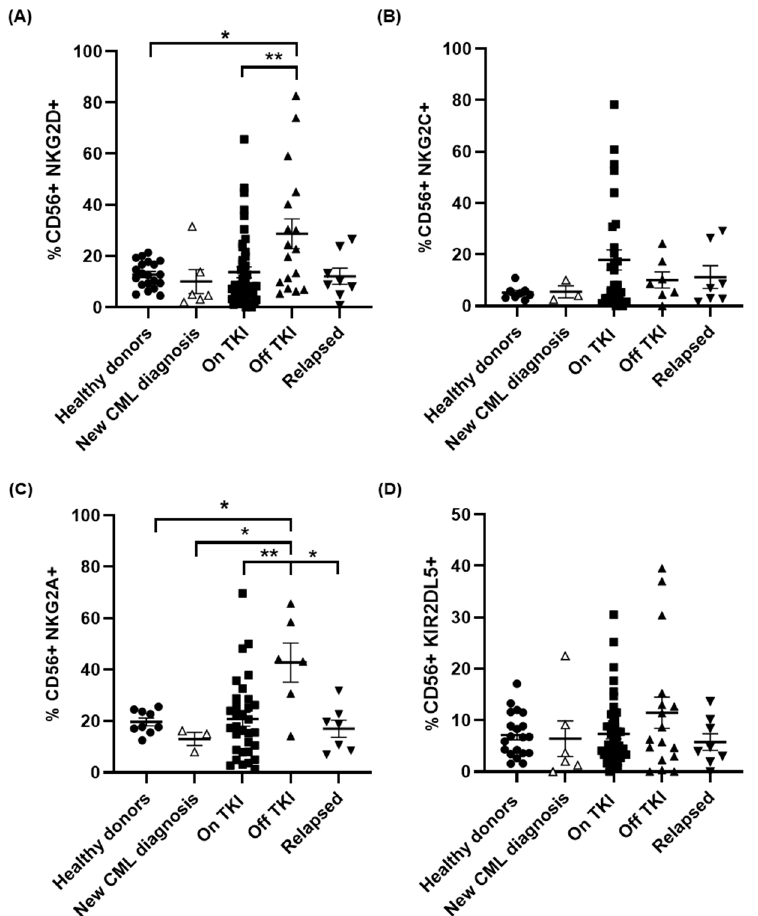
Figure 3. Differential expression of activating or inhibitory receptors in NK cells in the different groups of patients. Analysis by flow cytometry of the expression of the NK activating markers NKG2D ( A ) and NKG2C ( B ) and the NK inhibitory markers NKG2A ( C ) and KIR2DL5 ( D ) on the surface of CD56+ cells in peripheral blood of the different groups of patients and healthy donors (Healthy donors ( ● ), new CML diagnosis ( △ ), patients On TKI ( ■ ), patients Off TKI who did not relapse ( ▲ ), patients Off TKI who relapsed ( ▼ )). Each dot corresponds to one sample and lines represent mean ± SEM. Statistical significance was calculated using one-way ANOVA and Tukey’s multiple comparisons test. * p < 0.05; ** p < 0.01.